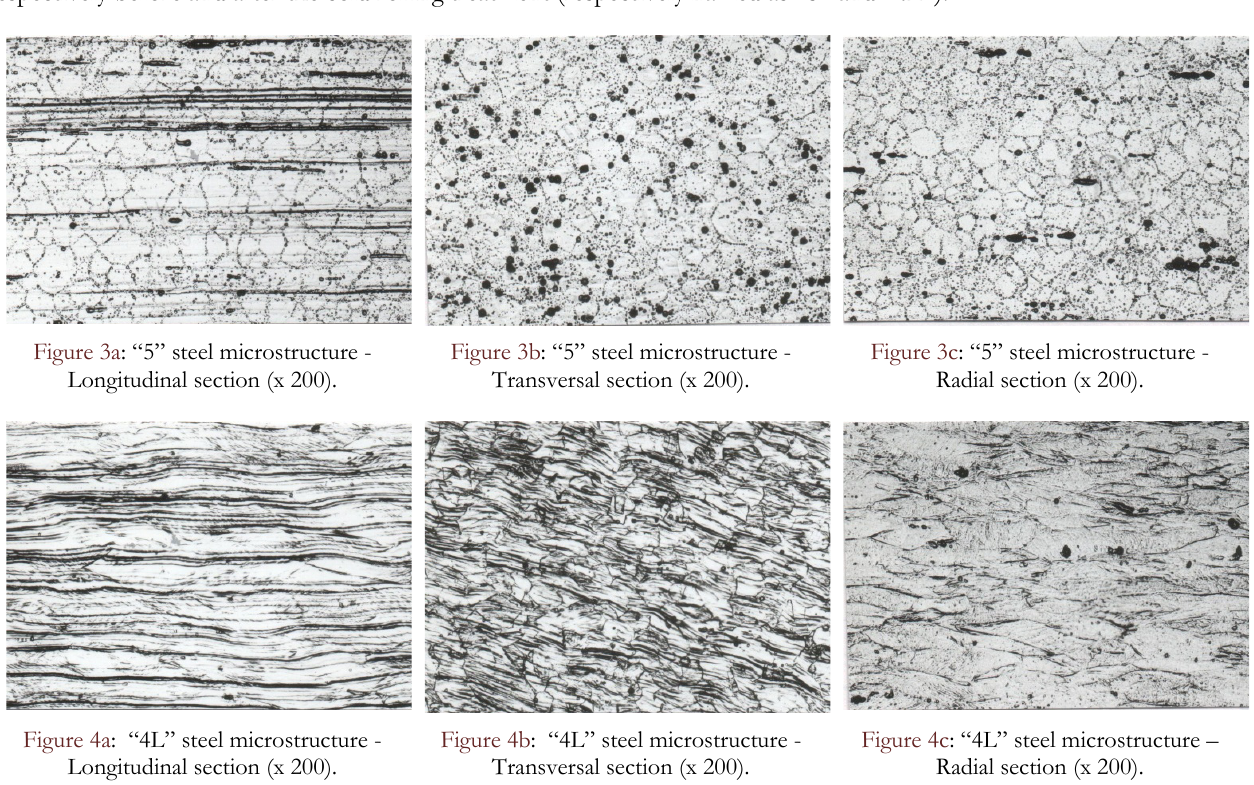
Figure 4a: “4L” steel microstructure - Longitudinal section (x 200).